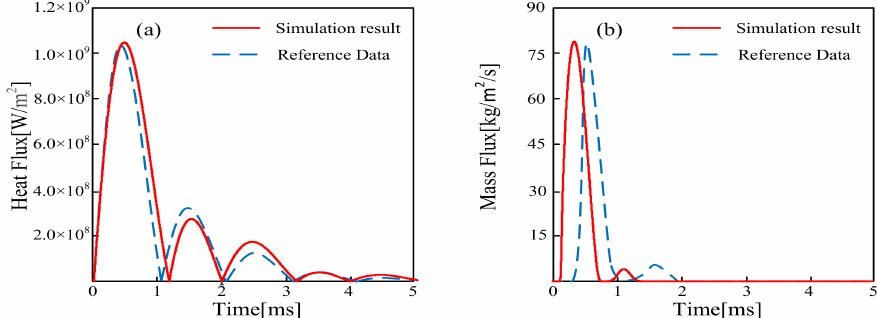
Figure 5. Comparison of heat flux and mass flux between simulation results and reference data from Stechman [31]: ( a ) heat flux variation with time; and ( b ) mass flux variation with